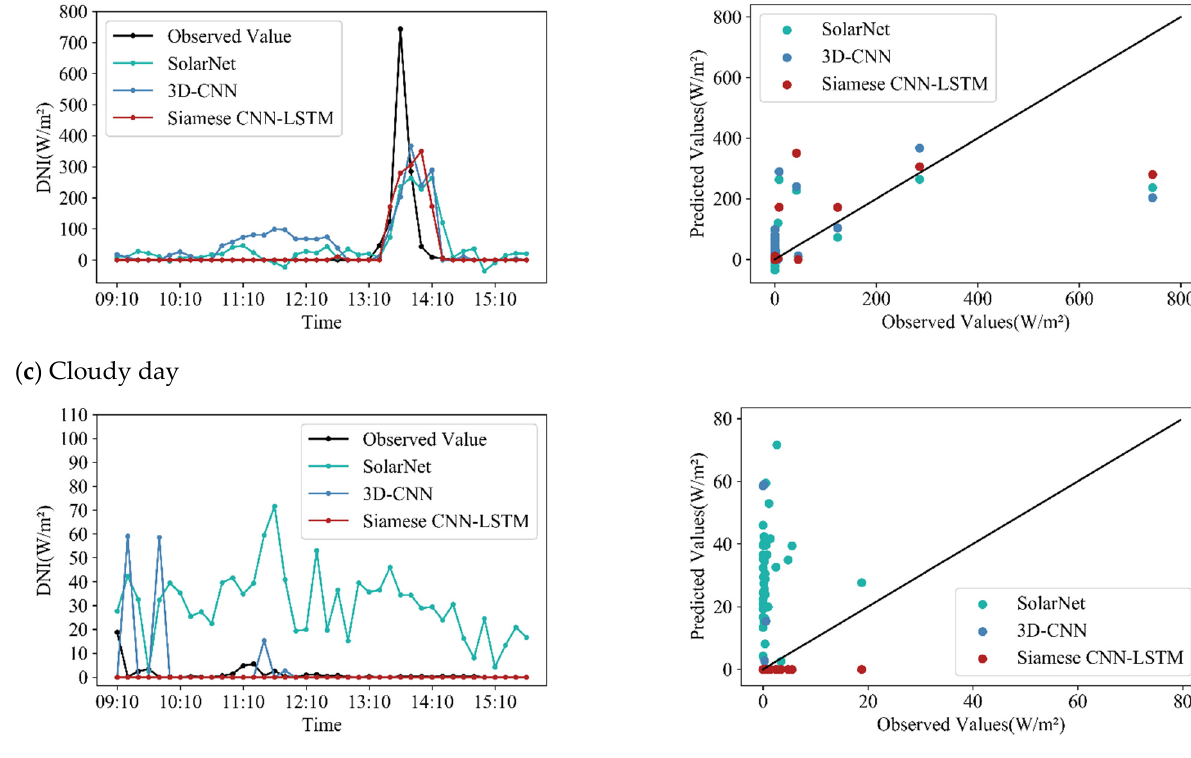
Figure 9. The predictions of the last three forecast models in Table 6 for four different weather conditions.